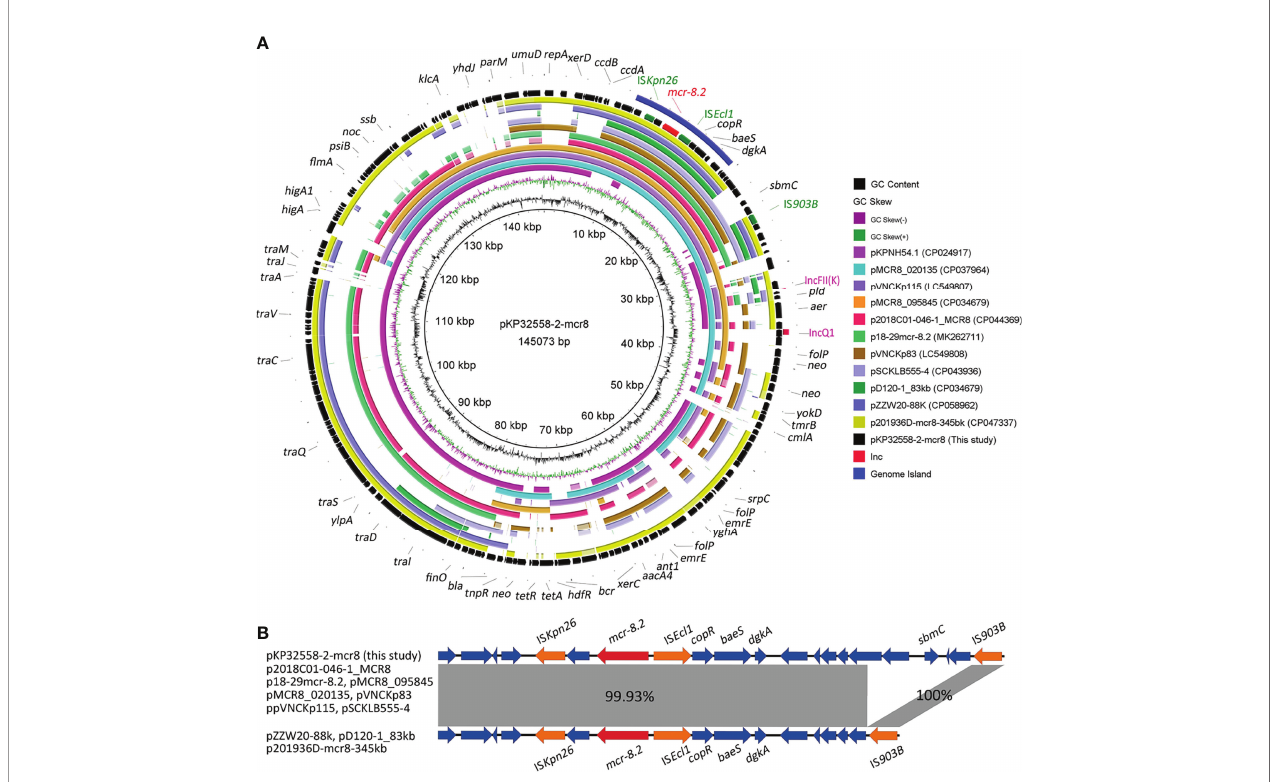
FIGURE 1 | Genetic features of the mcr-8.2 -carrying plasmid in K. pneumoniae strain KP32558. (A) Circular map of plasmid pKP32558-2-mcr8 and its reference plasmids. The outer blue circle is the genomic island region of plasmid pKP32558-2-mcr8. Red text on the plasmid map indicates mcr-8.2 gene, the green text indicates insertion sequences around mcr-8.2 , and pink text represents the replicons. (B) Genetic contents of mcr-8.2 gene. Coding sequences are indicated by arrows. Sequences of shared homology between two plasmids are marked by gray